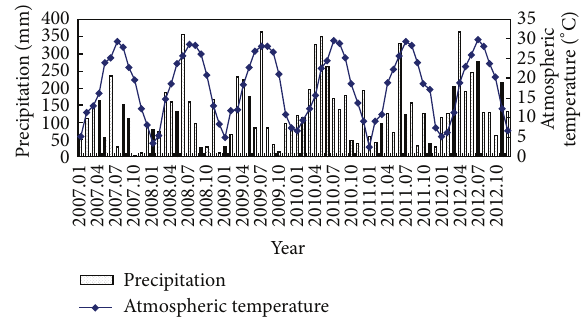
Figure 1: Monthly atmospheric temperature and precipitation dur- ing 2007–2012 in Fenyi